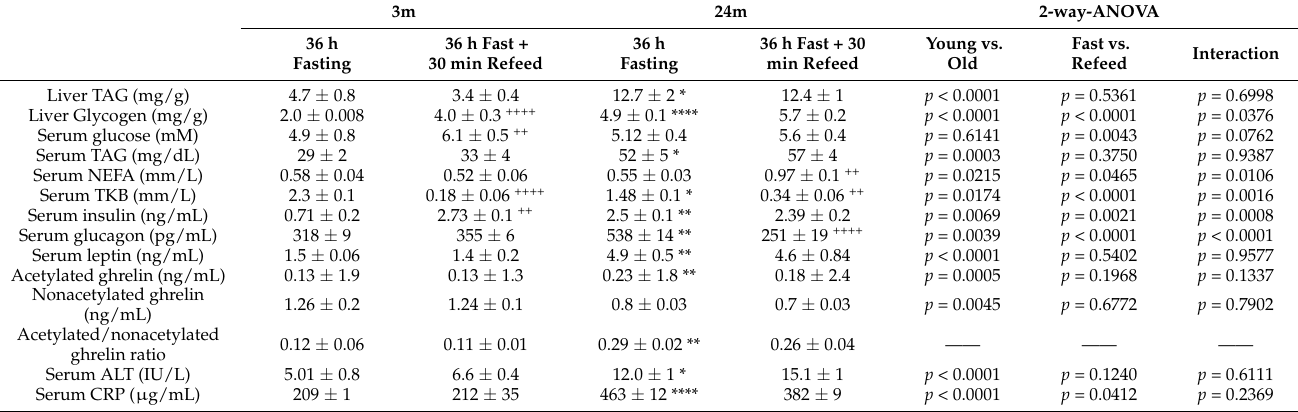
3m 24m 2-way-ANOVA 36 h 36 h Fast + 36 h 36 h Fast + 30 Young vs. Fast vs. Fasting 30 min Refeed Fasting min Refeed Old Refeed Interaction